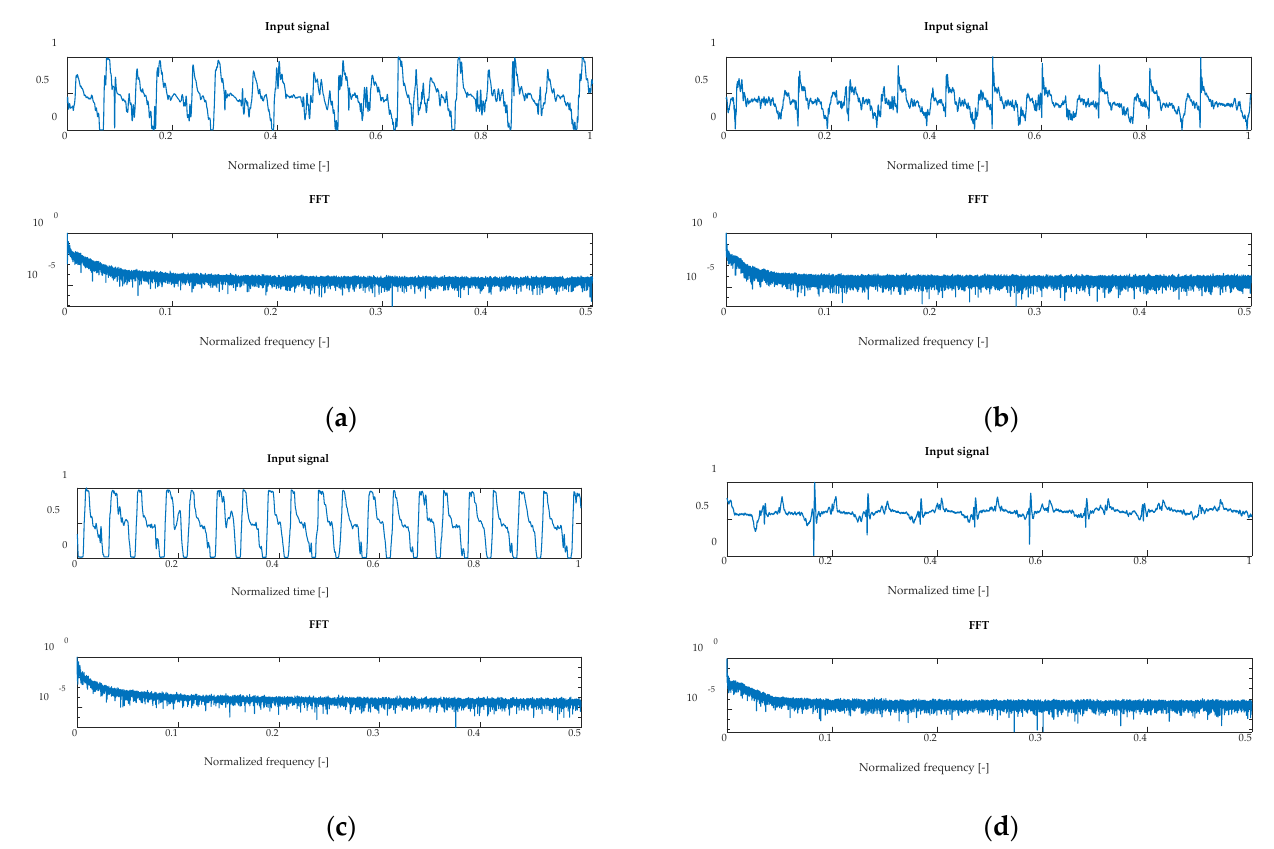
Figure 6. Examples of normalized signals for healthy and injured knees in the time and frequency domain for OKC and CKC recorded with a sensor placed on the lateral side. Respectively: ( a ) HC OKC, ( b ) OA OKC, ( c ) HC CKC and ( d ) OA CKC.